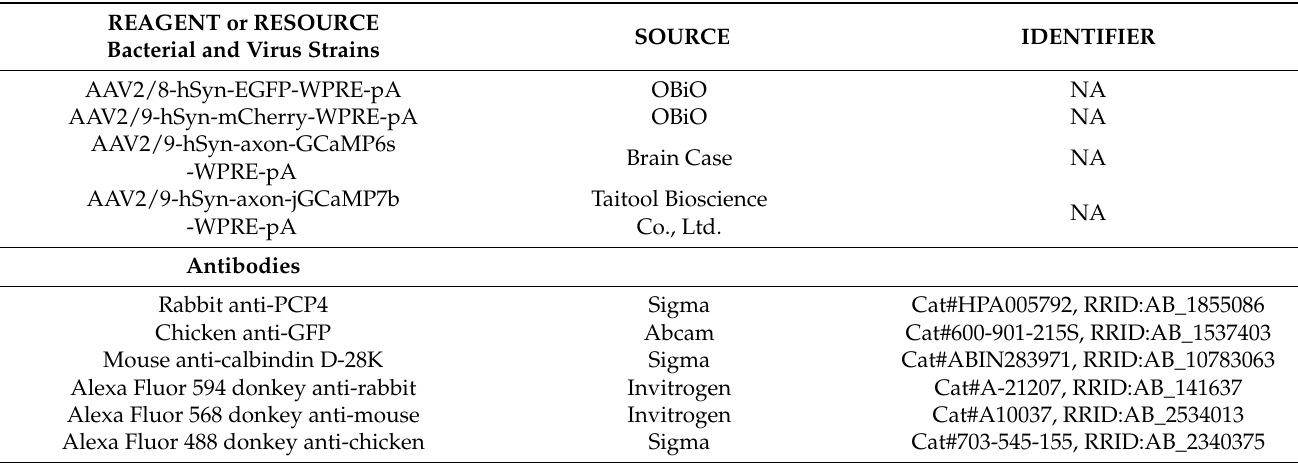
Table A1. Key experimental reagents used in the